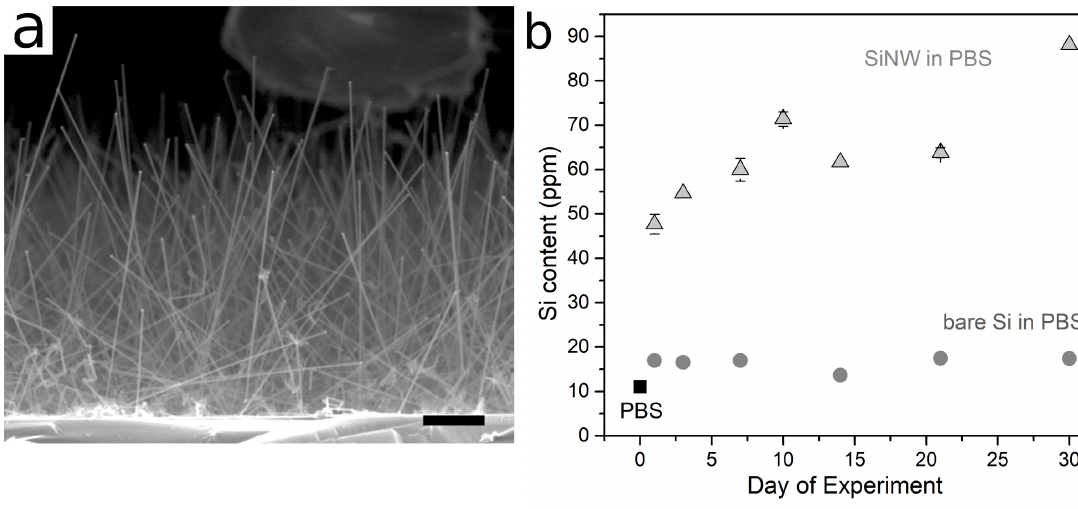
Figure 1. ( a ) SEM image of SiNW densely grown onto a Si wafer piece. Scale bar 1 µ m. ( b )